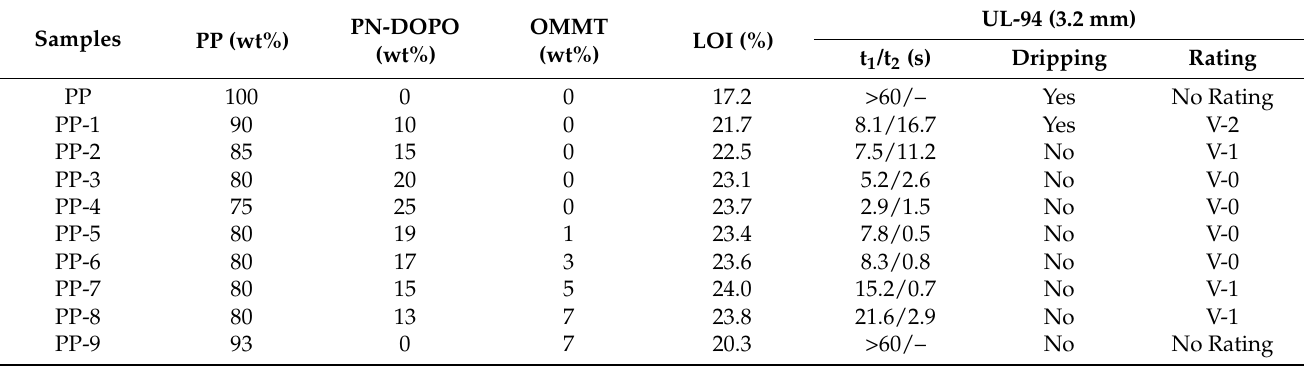
Table 1. Composition of the PP composites and results of UL-94 vertical combustion and LOI